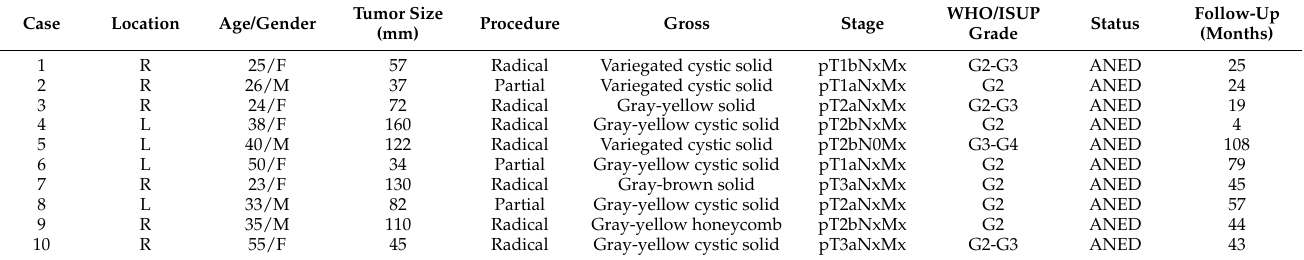
Table 1. Clinicopathological features and follow-up of TFEB rearranged renal cell carcinoma.